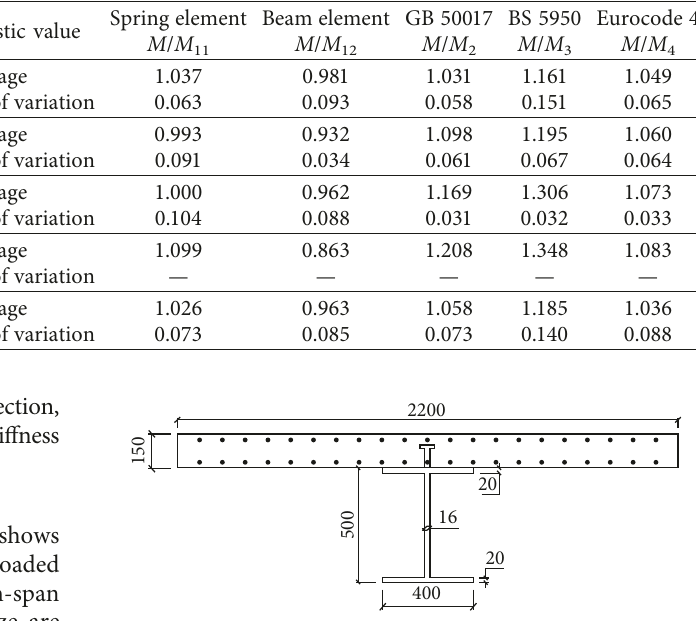
Figure 12: Geometric properties of a steel-concrete composite